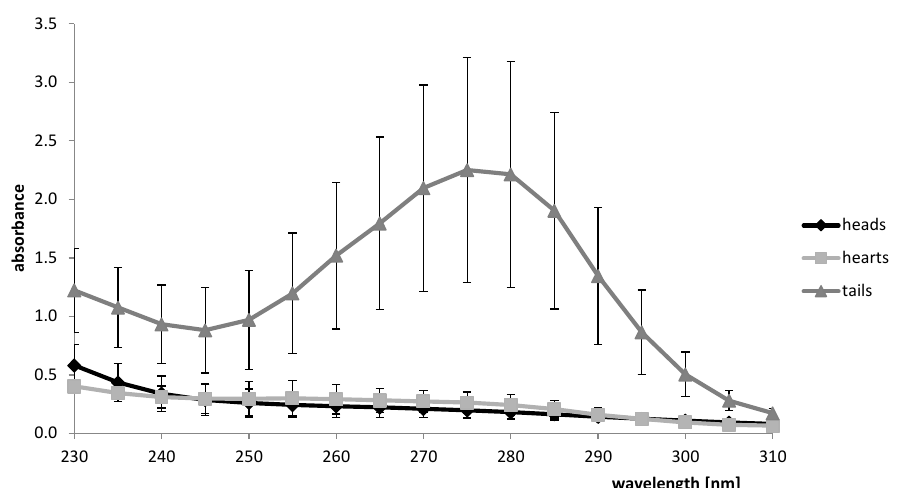
Figure 2. Principal component analysis of absorbance spectra of heads, hearts and tails fractions gained from distillates of mashes No. 1–10. Factor 1 explains 78.8% of the data variance. Factor 2 explains 16.4% of the data variance (cumulated = 95.2%). Wavelengths 230–310 nm (black), wave- lengths 315–1000 nm (grey).